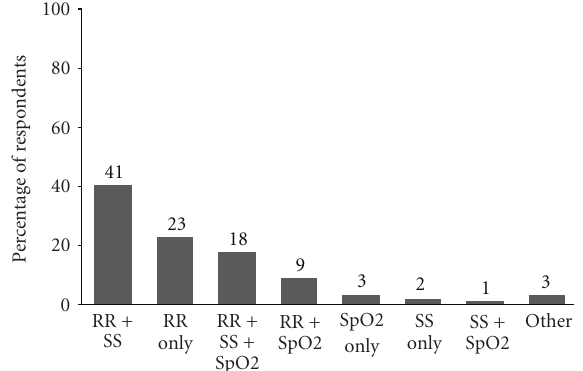
Figure 4: Types of Monitoring Used to Detect Respiratory Depres- sion. RR = respiratory rate, SS = sedation score, SpO2 = oxygen pulse